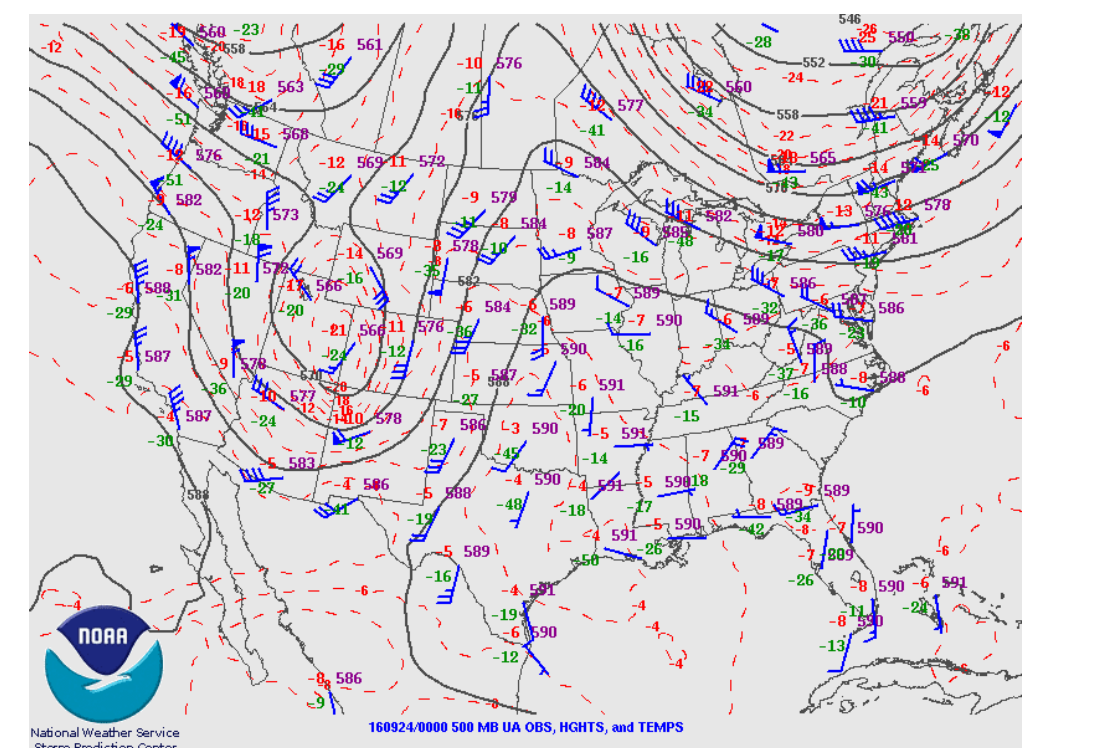
Figure A1. Pressure at 500hPa (black lines), temperature (dashed red), wind barbs (blue), temperature (red numbers), and dew point (green numbers). Source: National Weather